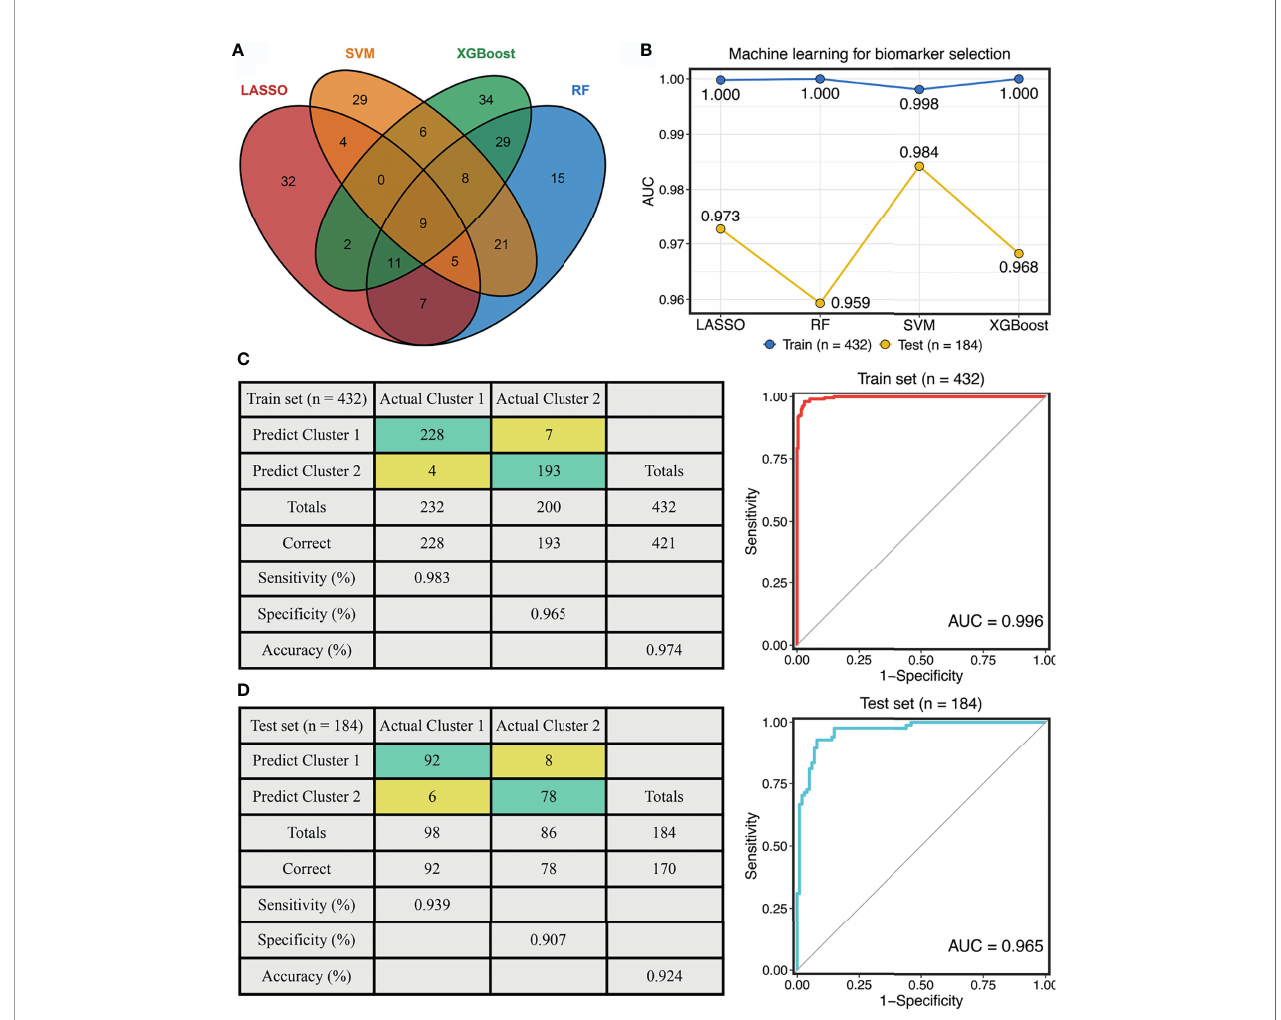
FIGURE 2 | Construction of the stemness cluster predictor. (A) Venn diagram identi fi ed nine key stemness subtype speci fi c genes that were shared by four feature selection algorithms. (B) The performances of four machine-learning algorithms for feature selection were evaluated in the training and testing sets. (C, D) The confusion matrices and ROC curves of the stemness clusters predictor in the training (C) and testing (D)